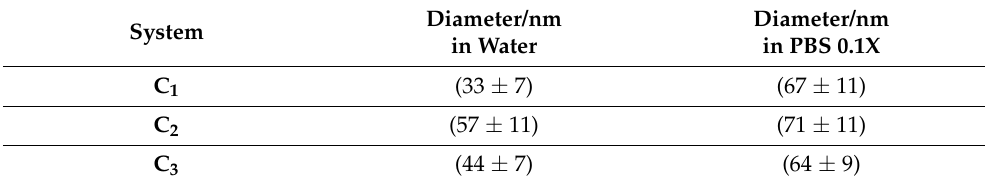
Table 2. Dynamic light scattering (DLS) size distribution by number of